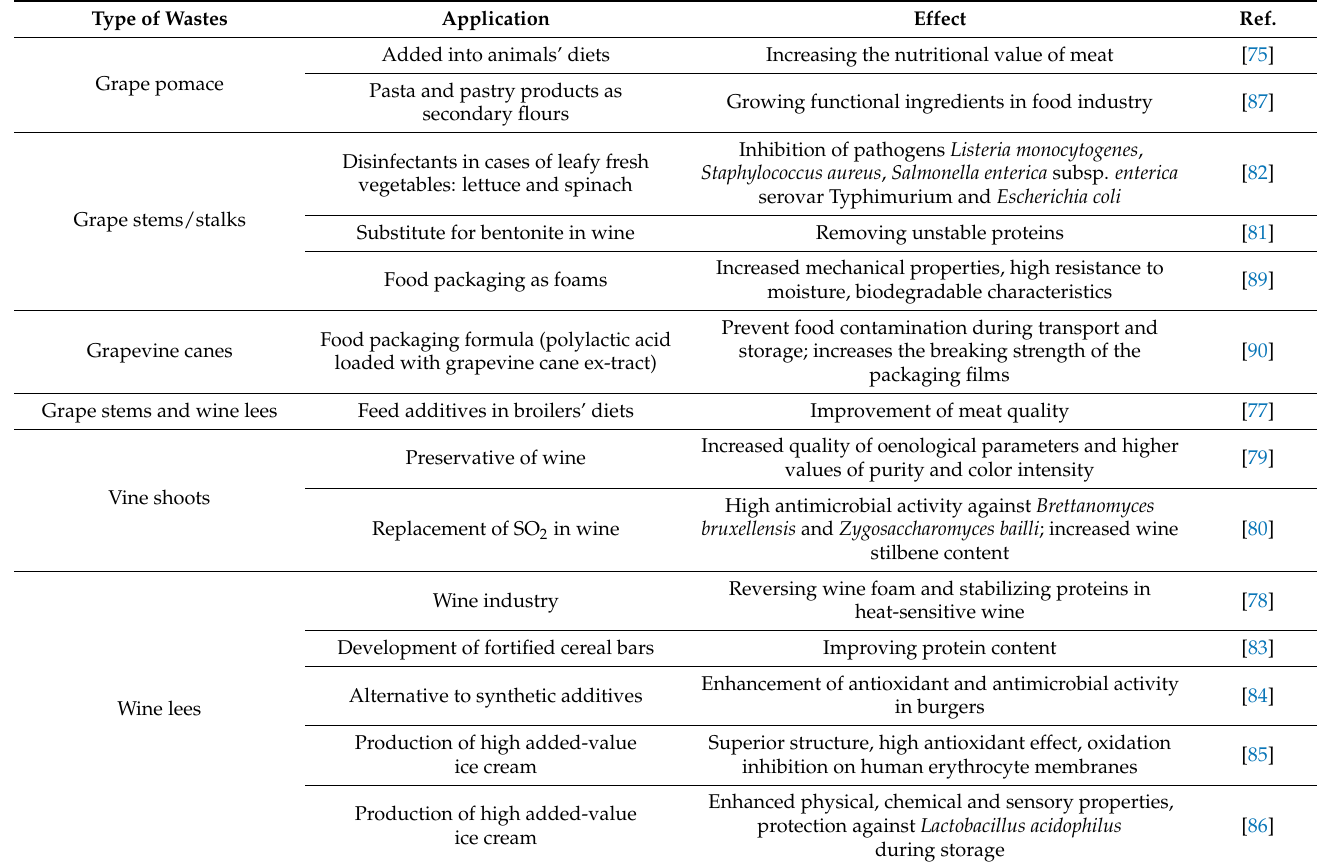
Table 3. Applications of grapevine wastes-derived products in food and beverage